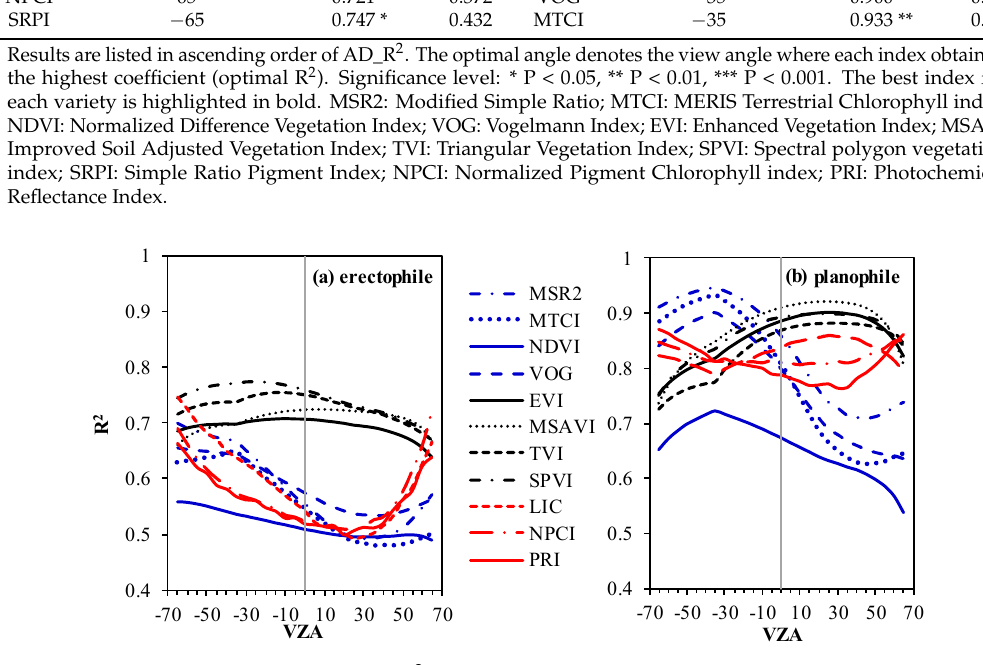
Figure 4. Coefficients of determination (R 2 ) of the linear relationships between LAI and selected VIs at different VZAs in PP for ( a ) erectophile and ( b ) planophile varieties based on the measured datasets.